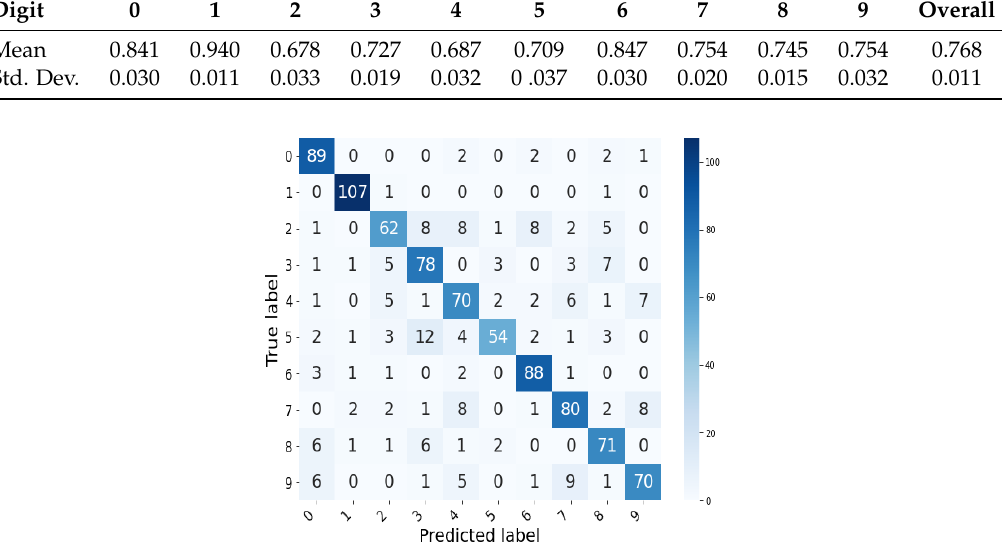
Figure 9. Confusion matrix for the average prediction of the random forest over a 10-fold cross